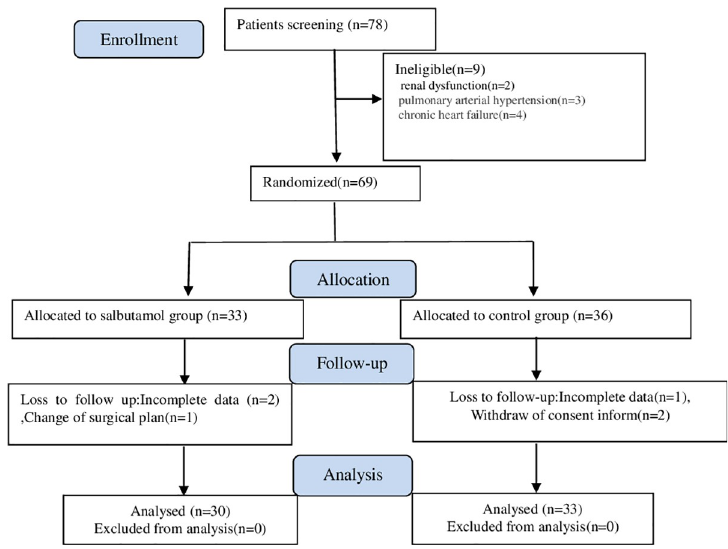
Fig 1. Consolidated Standards of Reporting Trials (CONSORT) flow chart for this